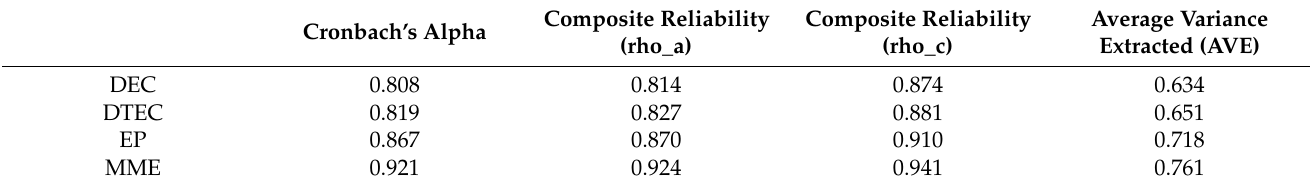
Table 3. Construct reliability and validity.